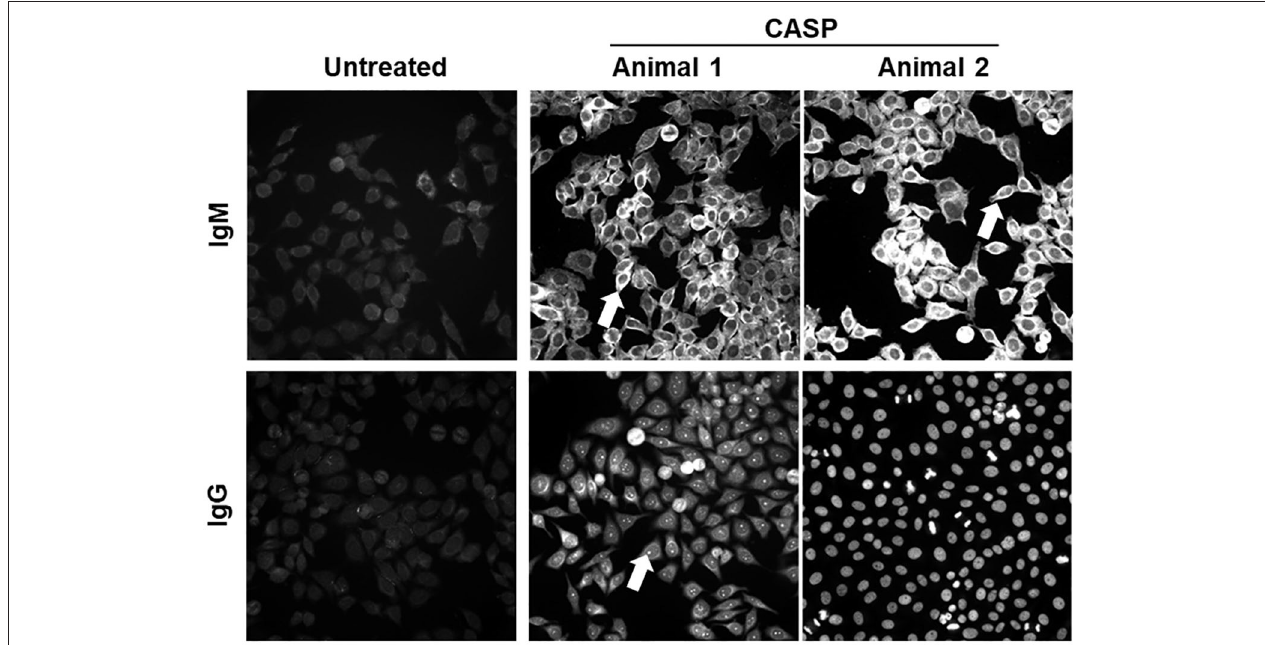
FIGURE 2 | Serum antibodies directed against self-antigens 14 days after sepsis induction. Sepsis was induced in C57BL/6 mice by 18G CASP. Control mice remained untreated. Fourteen days later blood was taken, and sera diluted 1:100 in 20% FCS/PBS were incubated on HEp-2-ANA slides. Bound antibodies were detected by FITC-labeled anti-mouse IgM or IgG antibodies. Out of the tested serum antibodies, 12/13 IgM and 12/13 IgG antibodies were autoreactive. Shown are representative pictures of septic and control mice. N = 8 per group. Serum IgM and IgG binding patterns varied greatly. In most cases more than one cellular structure is stained, albeit at variable